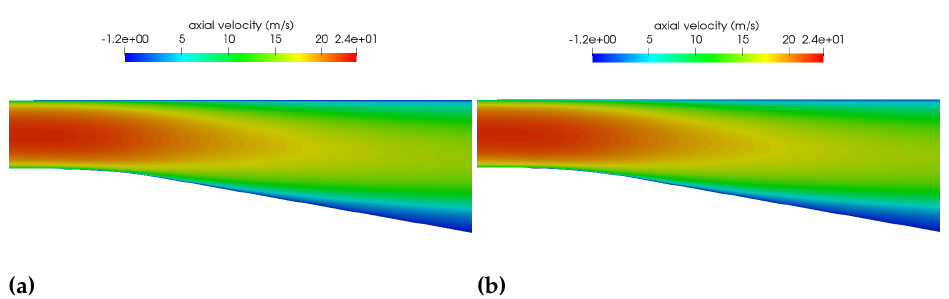
Figure 19. Axial velocity distribution as produced by the (a) commercial package and (b) the current solver